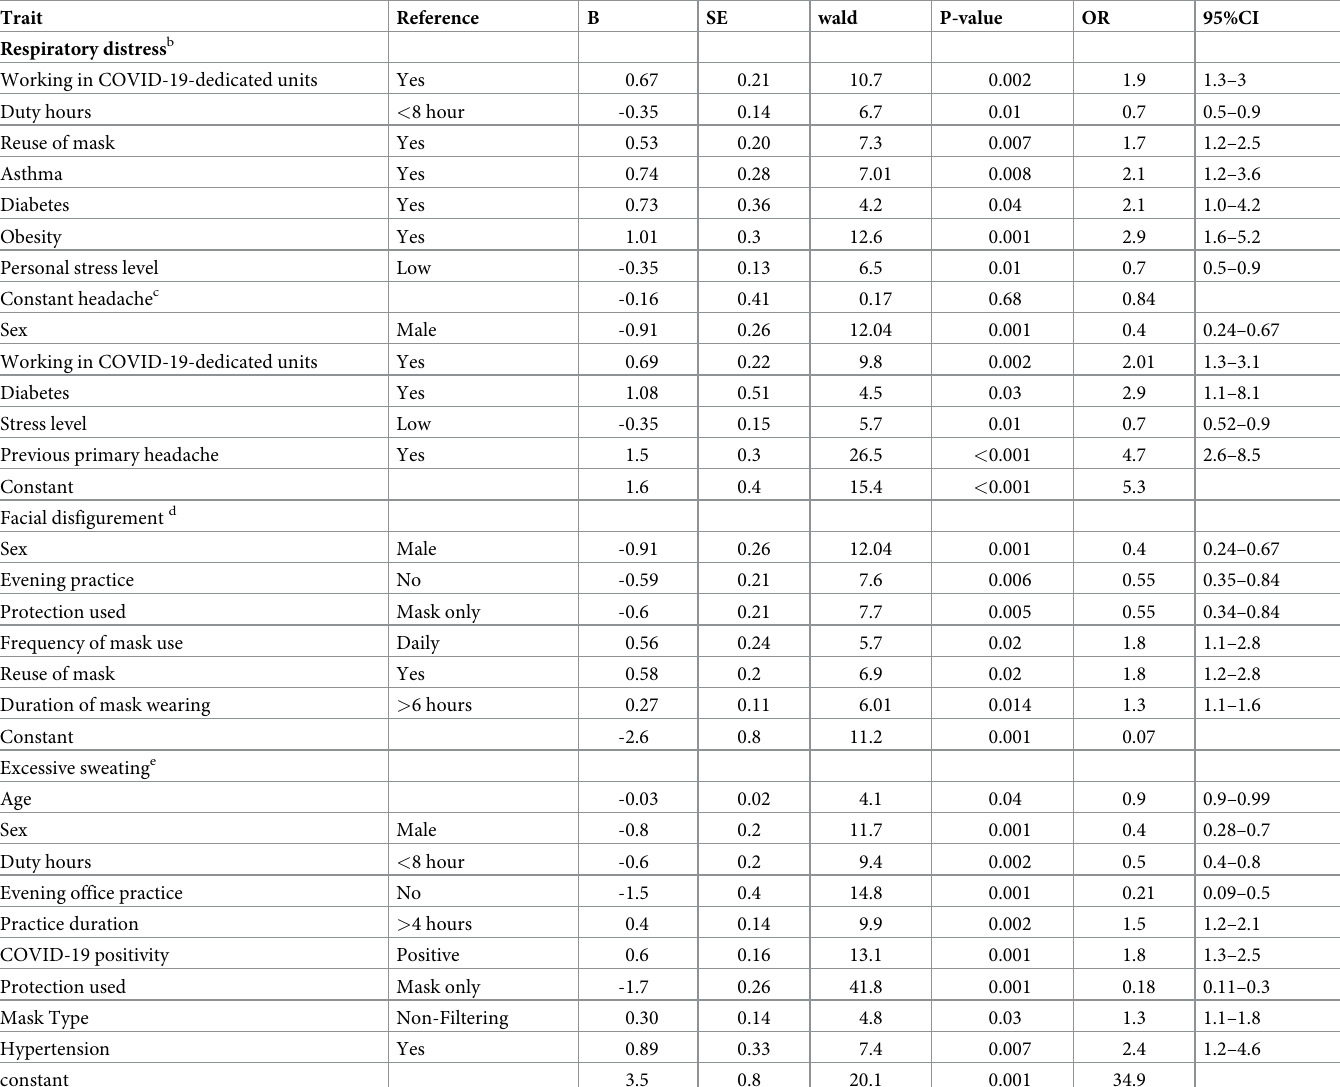
Table 3. Risk factors a of respiratory distress, headache, facial disfigurement, and excessive sweating.